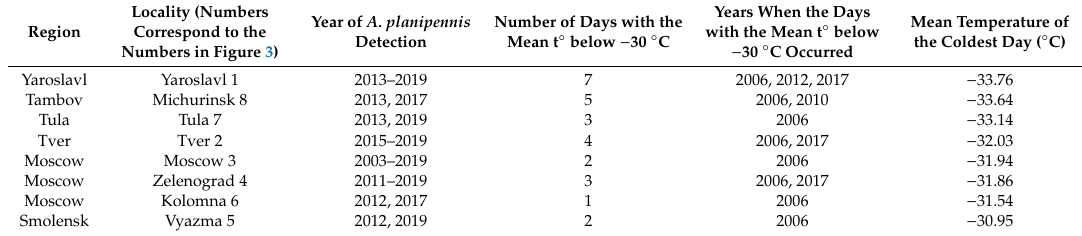
Figure 3. Minimum mean daily temperatures recorded from 2003 to 2019 in the territories currently occupied by A. planipennis in Europe (Russia and Ukraine). Some localities where the daily temperature fell below − 30 °C are numbered. Detailed information for each of these localities is provided in Table 3. Table 3. Some Agrilus planipennis localities in European Russia where the mean temperature of the coldest day from 2003–2019 was below − 30 °C *.